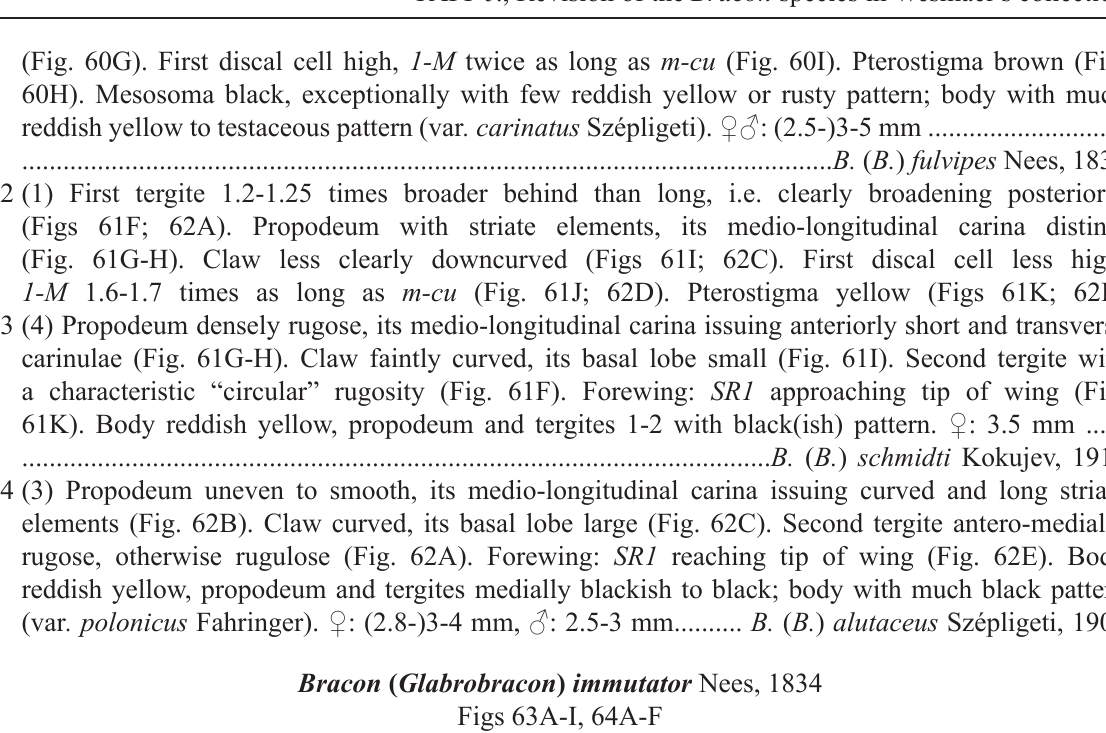
Figs 63A-I, 64A-F